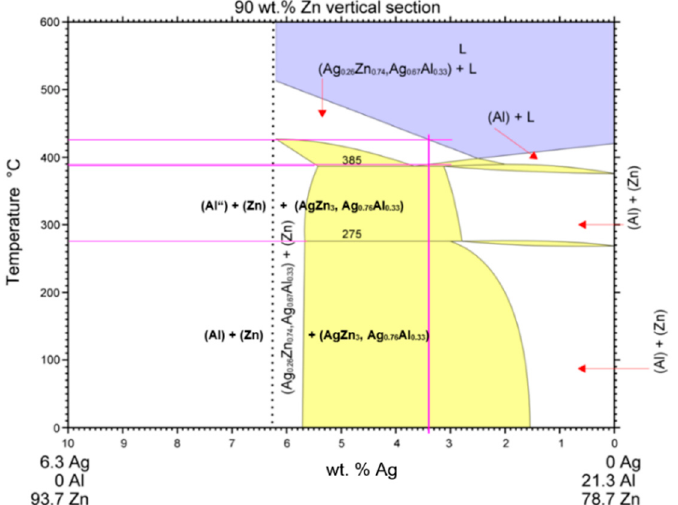
Figure 5. Isoplethic cross-section through the ternary system of Ag–Al–Zn for 90 wt.% Zn [26].